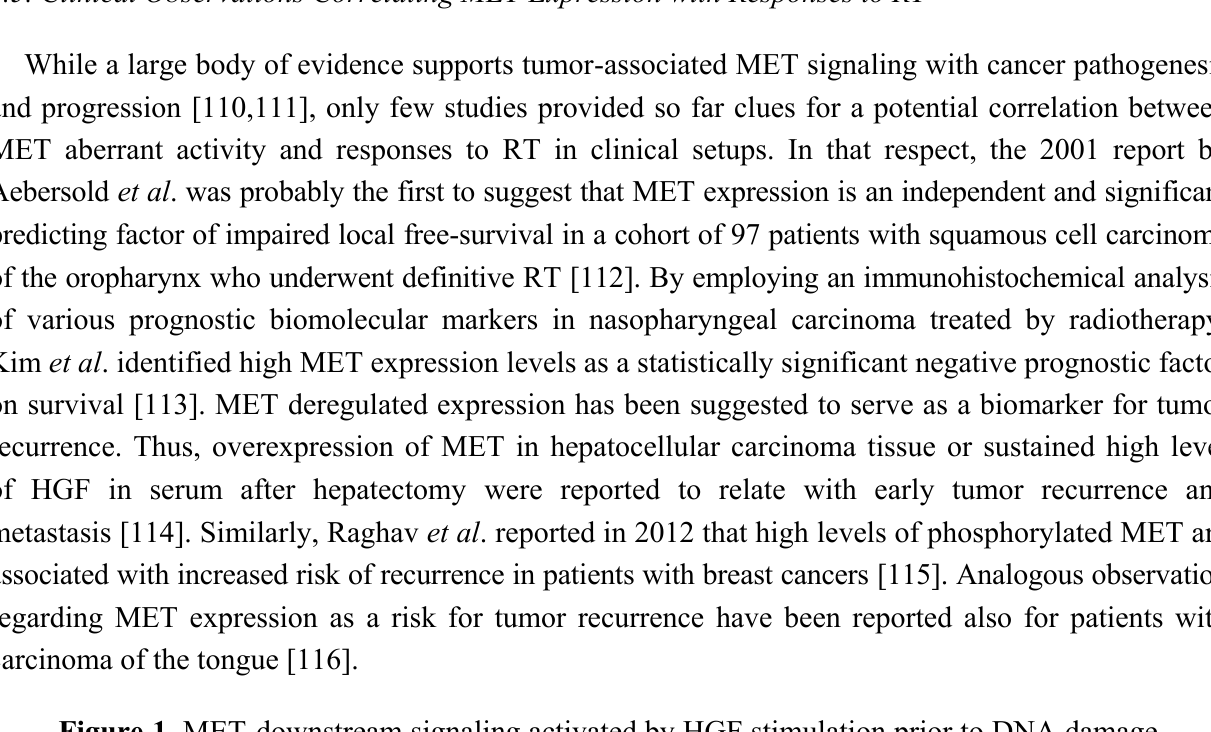
Figure 1. MET-downstream signaling activated by HGF stimulation prior to DNA damage and involved in MET-driven protection of cancer cell from